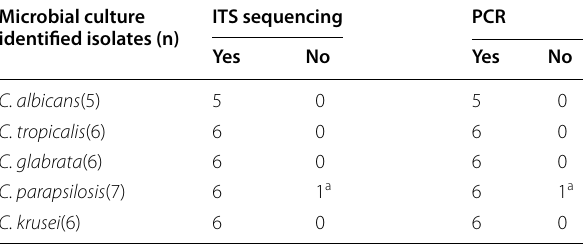
a One isolate identified as C. parapsilosis by microbial culture was identified as C. krusei both by ITS sequencing and PCR